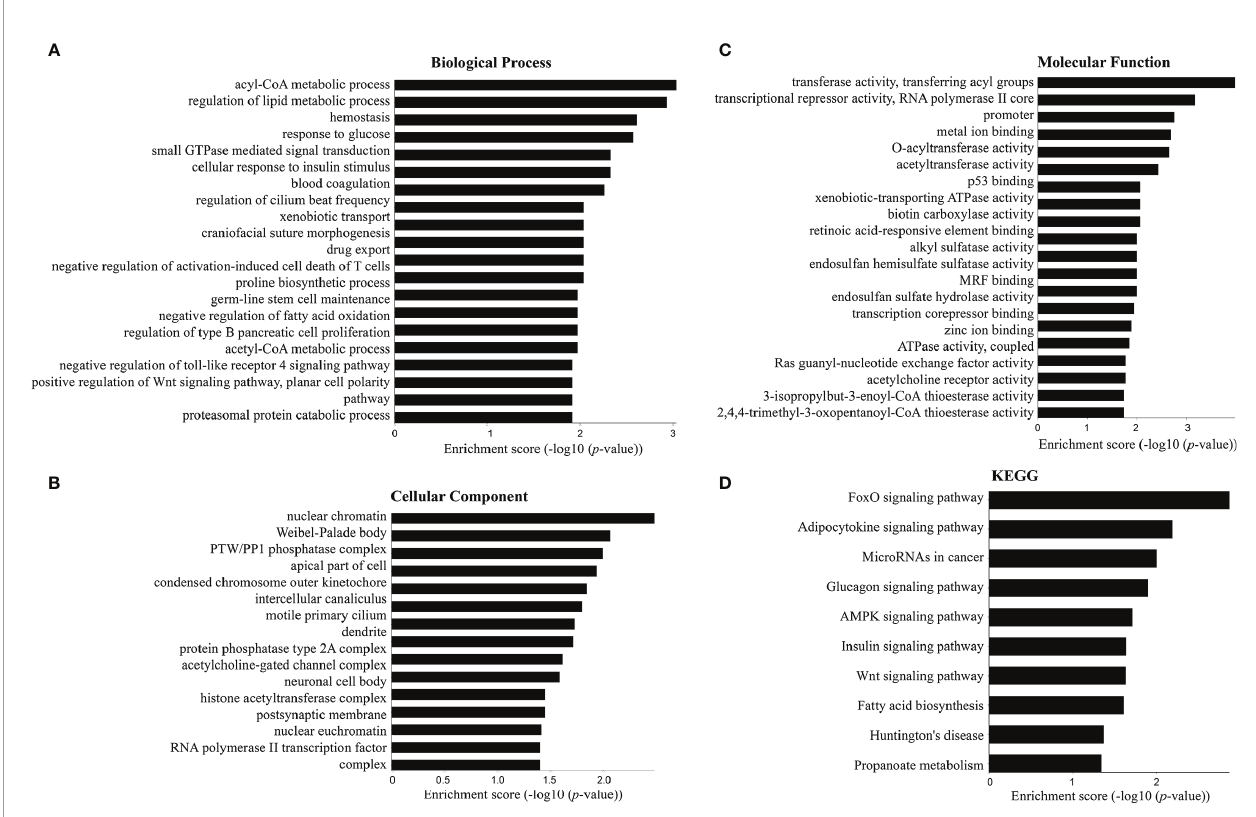
FIGURE 4 | Top 20 terms in the gene enrichment and pathway analysis of differentially expressed mRNAs induced by C. sinensis infection. (A) Biological process. (B) Cellular component. (C) Molecular function. (D) The most signi fi cant KEGG pathway for the differentially expressed